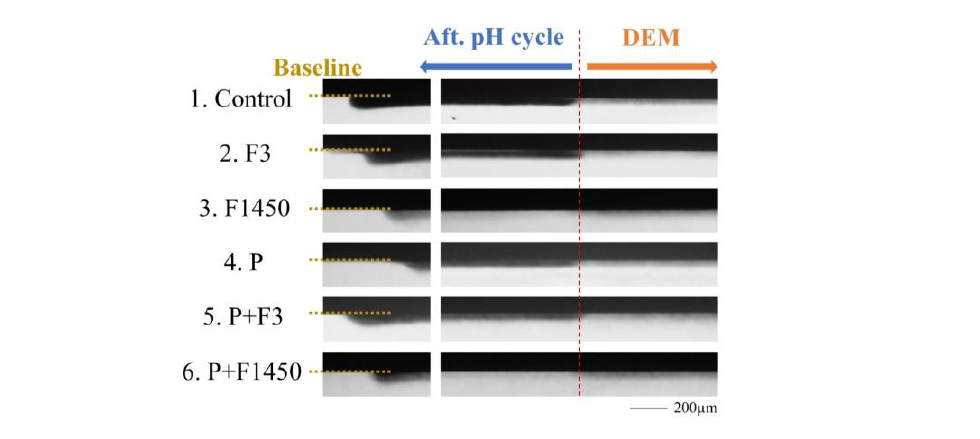
Figure 2. Transverse microradiographs of the DEM and aft. pH cycle zones including the treated enamel surface of the six groups.